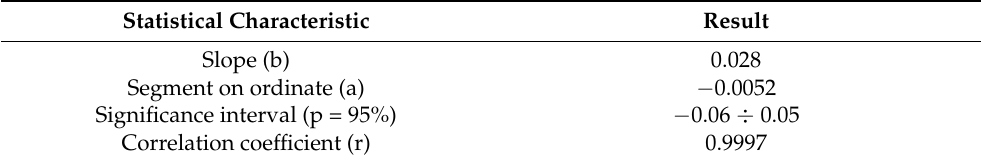
Figure 5. Dependence graph of ImpA measured integral signal intensity from its content in the sample. Table 2. Statistical Characteristics of Linear Regression.